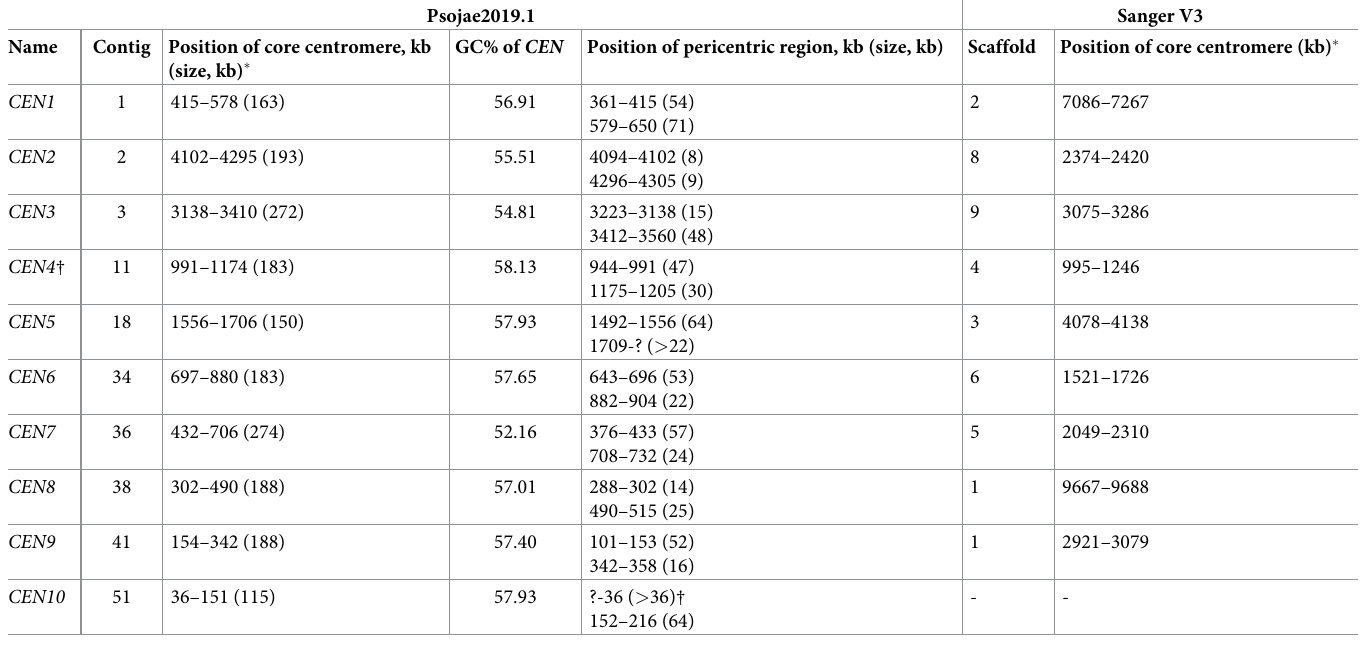
Table 1. Centromeres identified in the Psojae2019.1 assembly and their counterparts in the Sanger